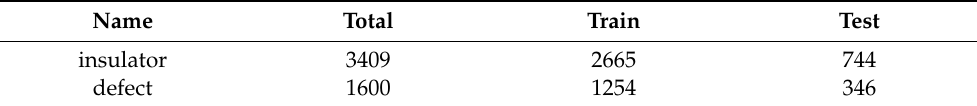
Table 2. Dataset label distribution table.